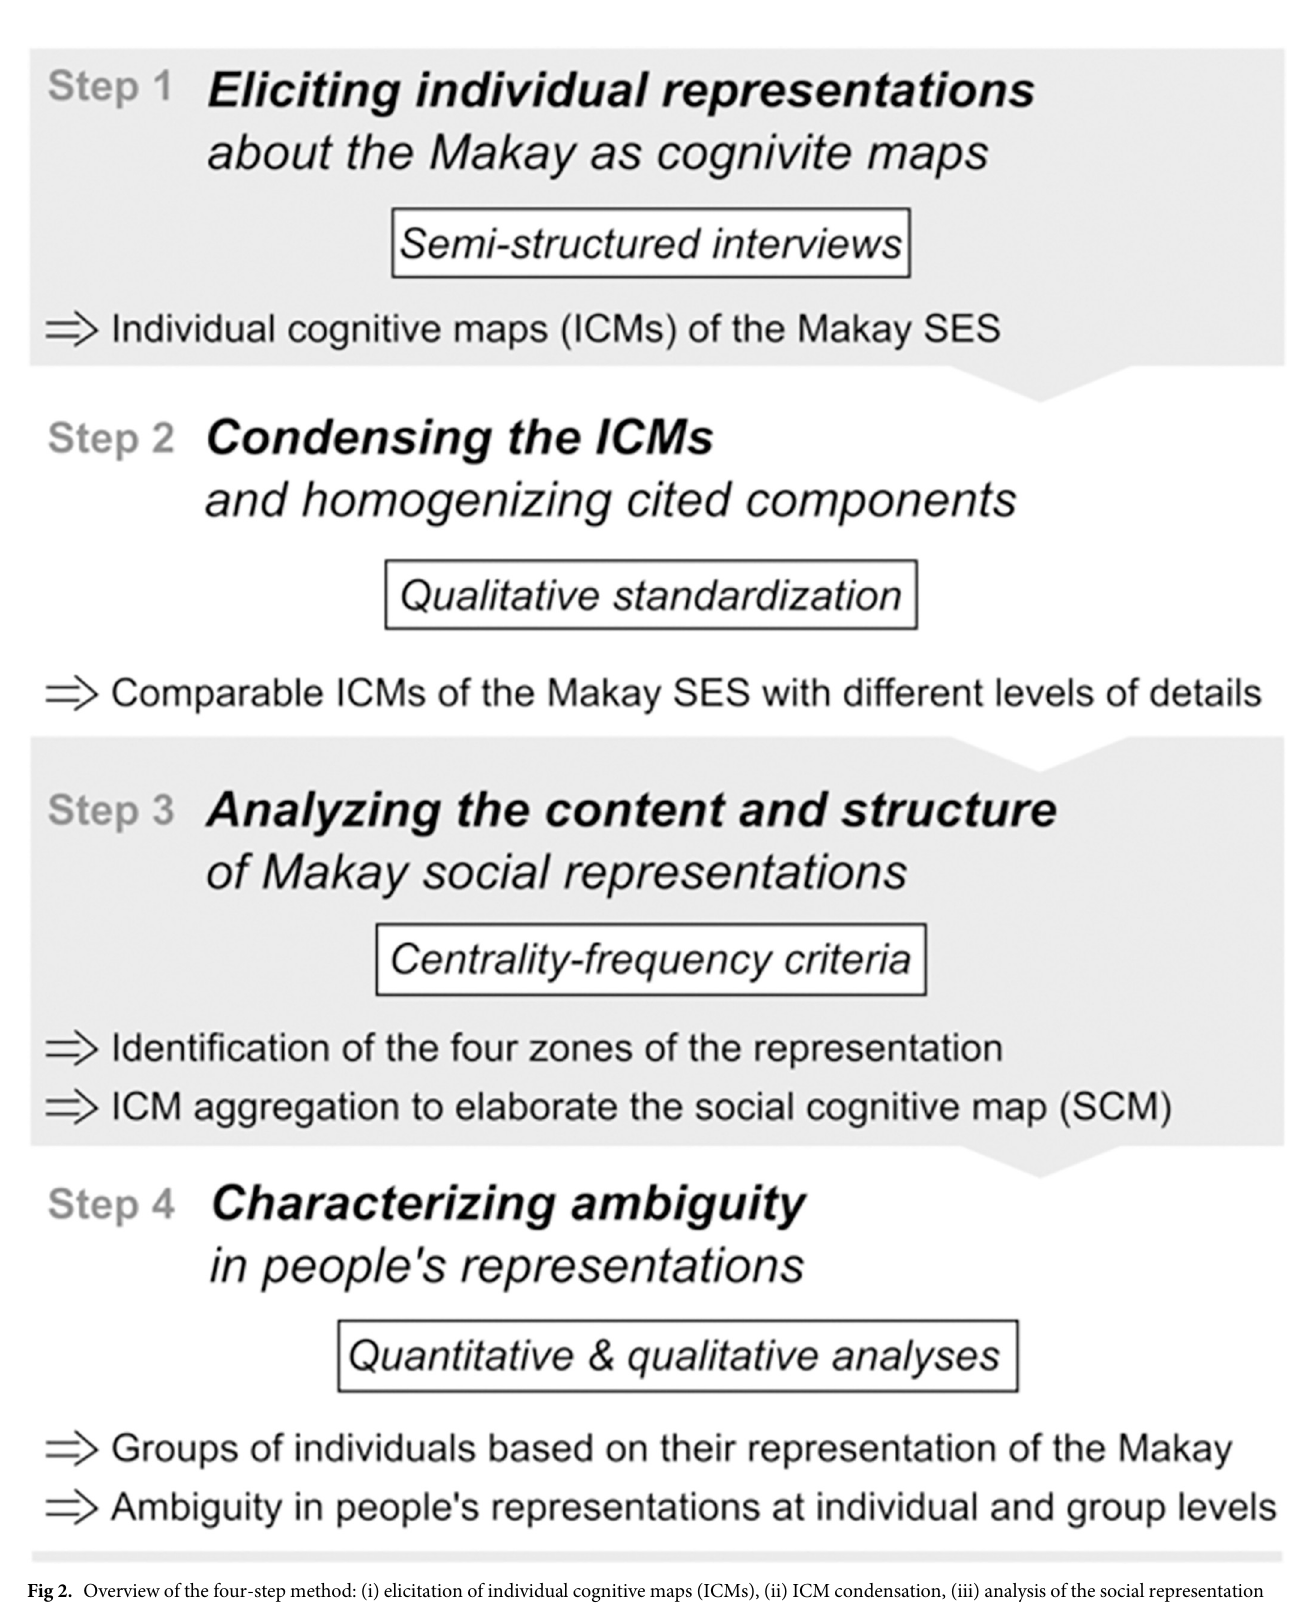
Fig 2. Overview of the four-step method: (i) elicitation of individual cognitive maps (ICMs), (ii) ICM condensation, (iii) analysis of the social representation and production of a social cognitive map (SCM) of the SES, and (iv) analysis of ambiguity at individual and group level through multivariate analyses and production of group cognitive